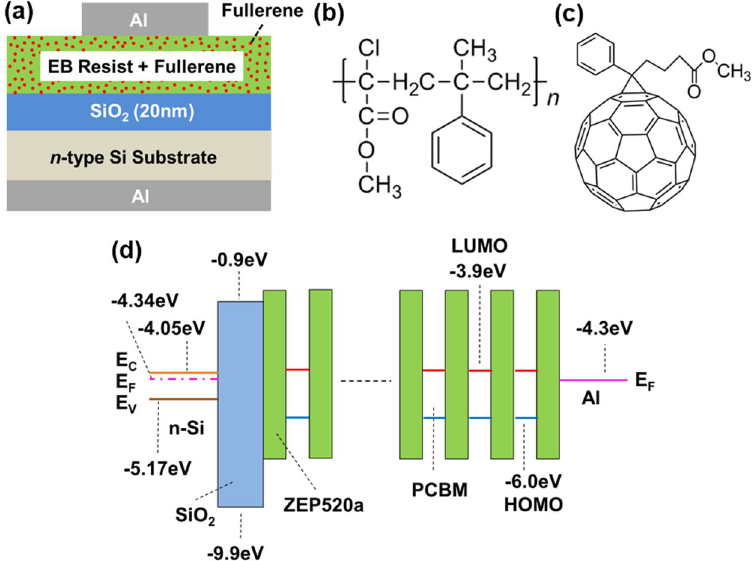
Figure 1. ( a ) Schematic diagram of fabricated capacitor with Al/electron-beam (EB) resist polymer containing fullerene/SiO 2 / n -type Si substrate. Chemical structure of ( b ) ZEP520a and ( c ) [6,6]-phenyl-C 61 butyric acid methyl ester (PCBM). ( d ) Band diagram of nanocomposite resist polymer containing PCBM in the equilibrium